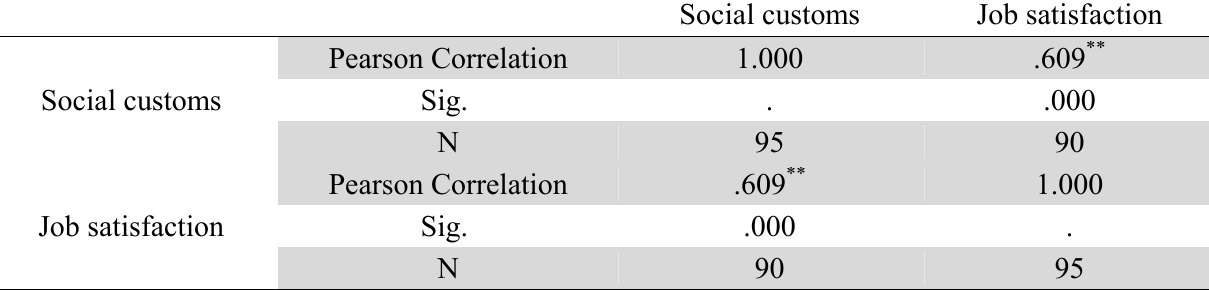
The summary of testing the relationship between social customs and job satisfaction Social customs Job satisfaction Pearson Correlation 1.000 .609 ** Social customs Sig. . .000 N 95 90 Pearson Correlation .609 ** 1.000 Job satisfaction Sig. .000 . N 90